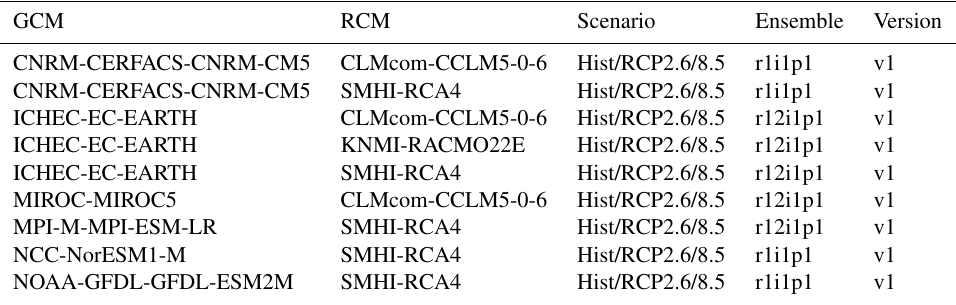
Table 2. CORDEX model chains used in this